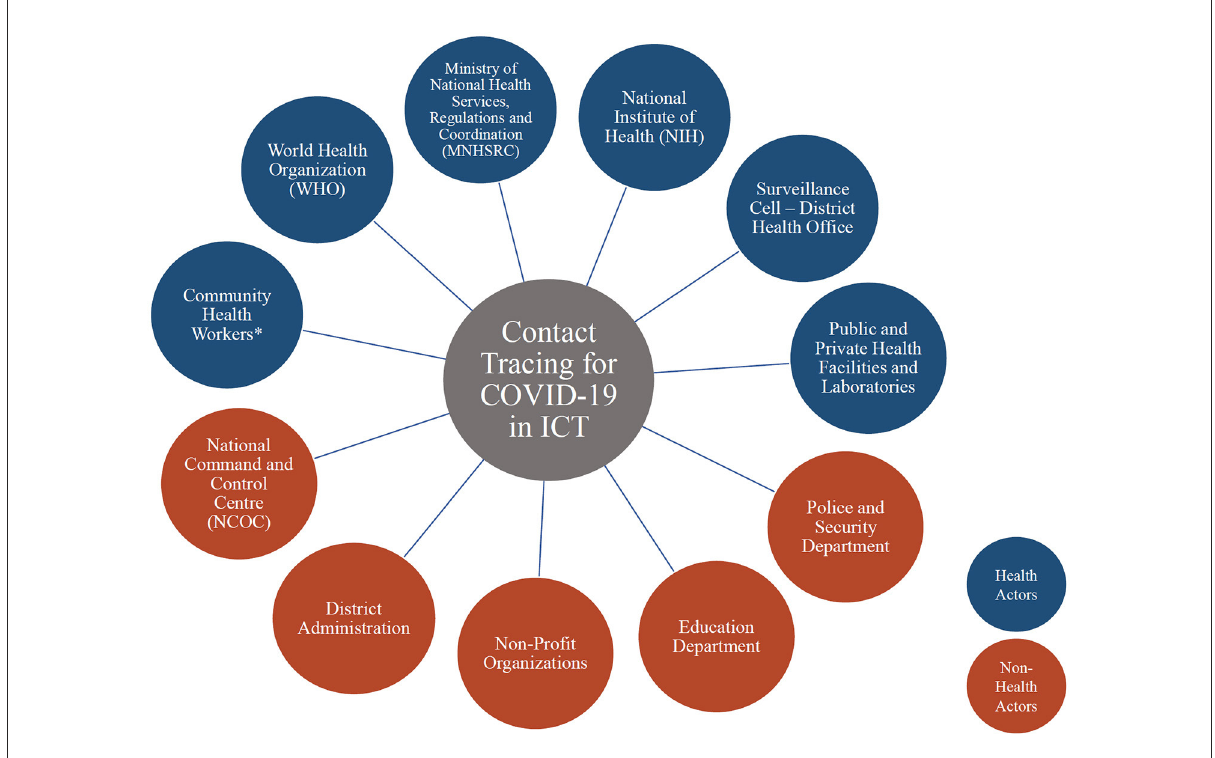
FIGURE1 Stakeholders for the ICT COVID-19 contact